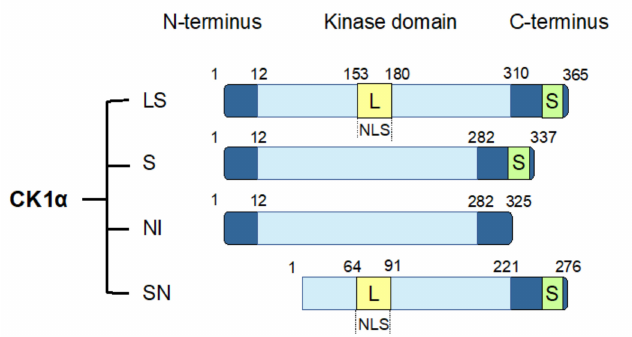
Figure 2. CK1 α splice variants. Human CK1 α undergoes alternative splicing to produce four splice variants, as shown. These CK1 α splice variants are characterized by the insertion of two polypeptide sequences: a long insertion (L) that contains a nuclear localization signal (NLS) into the protein kinase domain, and a short insertion (S) close to the C-terminus. LS: CK1 α with both L and S inserts; S: CK1 α with only an S insert; NI: CK1 α with no insert; SN: CK1 α LS with an N-terminal